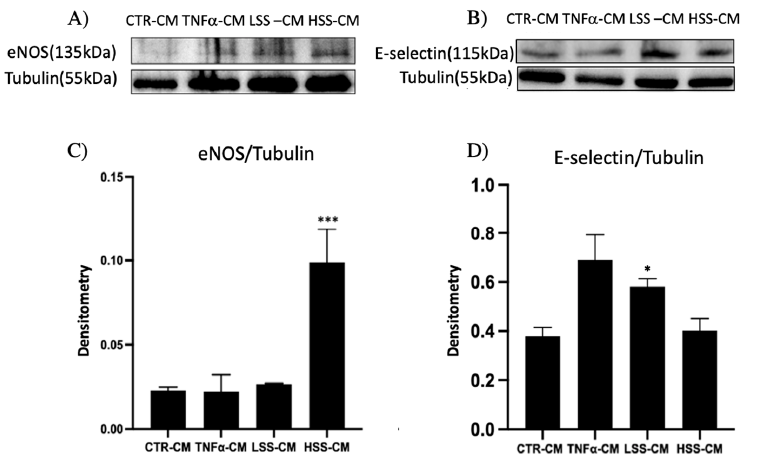
Figure 7. Western blot analysis of HUVEC cell lysates after 24 h of stimulation with TNF α -, LSS- and HSS-conditioned media (-CMs). ( A , B ) show the expression of eNOS and E-selectin, respectively, while ( C , D ) represent the normalization data by using tubulin expression level (* p < 0.05 and *** p <